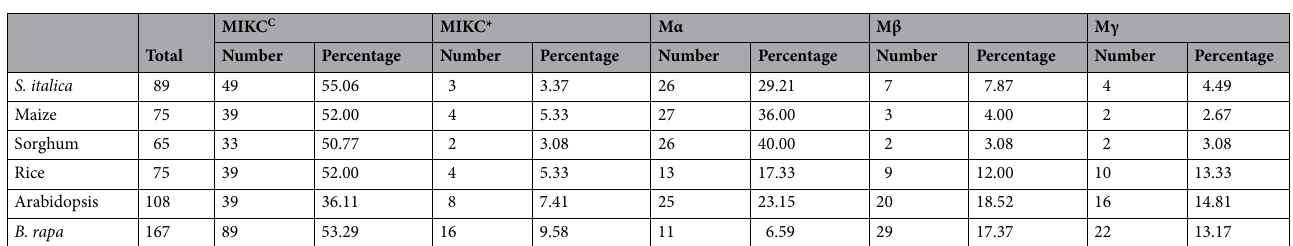
Table 1. The number and proportion of each type of MADS-box genes in foxtail millet, maize, sorghum, rice, Arabidopsis and Brassica